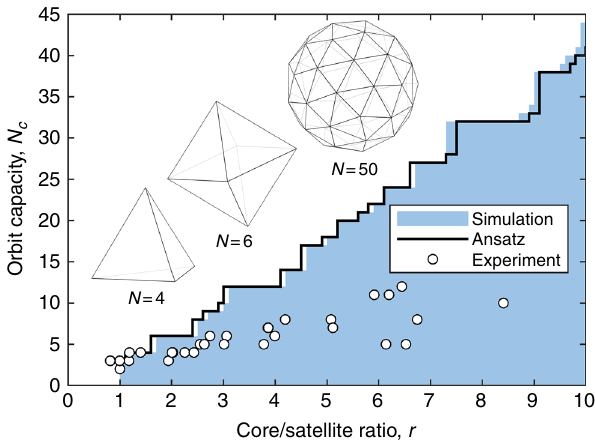
Fig. 3 Primary orbit capacity and packing. Orbit capacity N as a function of the core to satellite size ratio r illustrating numerical space of possible values (blue shading), estimated maximal orbit capacity from the ansatz (black line), a representative selection of experimental results achieved with water in E7 in water double emulsions (circles). Shapes corresponding to N = 4, N = 6, and N = 50 are shown above the